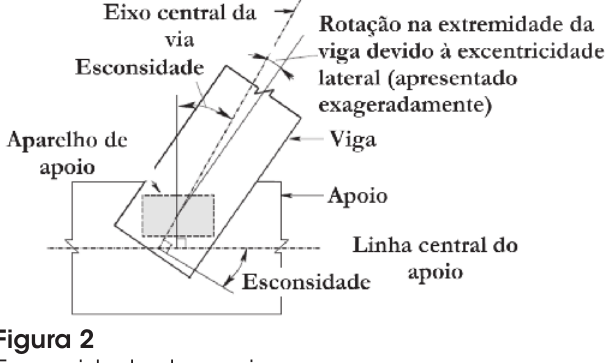
Curvatura vertical da viga Fonte: Adaptado de Consolazio e Hamilton